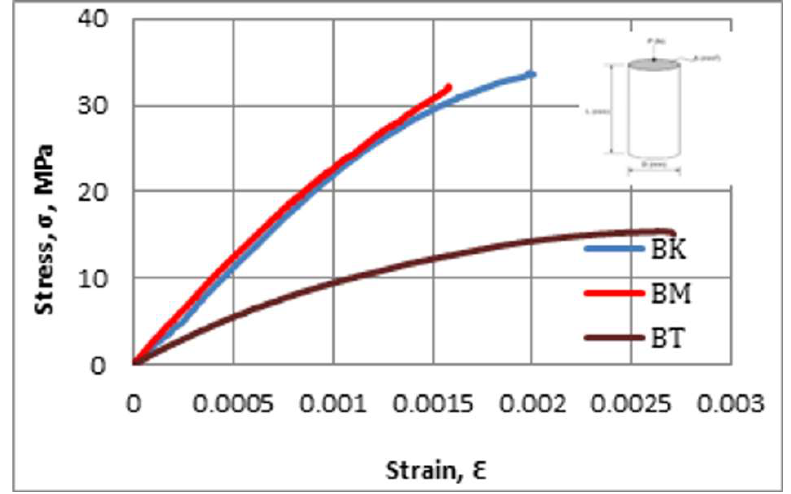
Figure 5. Stress–strain relationship of concrete. Table 5. Compressive strength and elasticity modulus of each